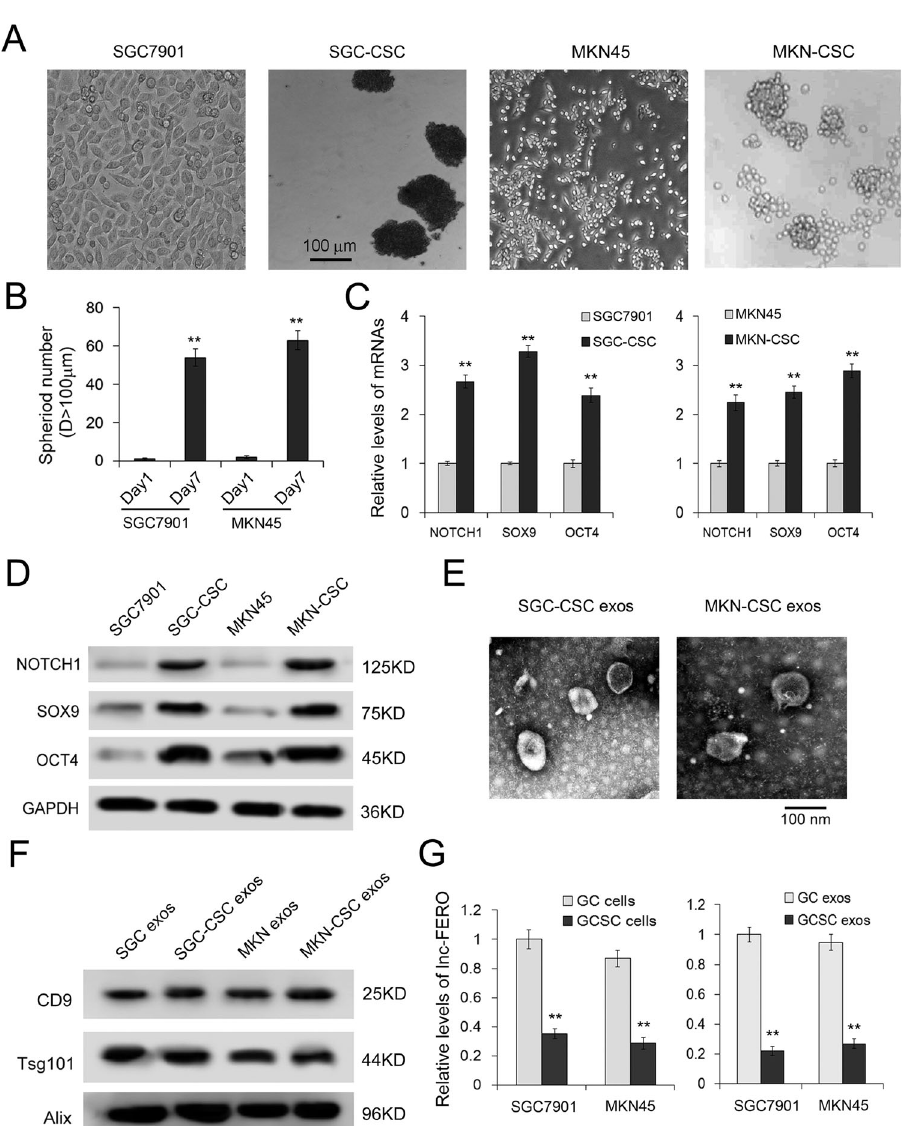
Fig. 3 The different expression characters of lncFERO in GC cells and GC stem cells. A Sphere-formation assays were performed in indicated cell lines. B Number of tumorspheres ( n = 3). C qRT-PCR analysis of stemness-associated genes, including NOTCH1, SOX9, and OCT4, in GC and GCSC cell lines ( n = 3). D Detection of stemness-associated genes by western blotting assay ( n = 3). E Exosomes images obtained from GCSCs were observed by using an electron microscope (scale bar, 100 nm). F Detection of exosome markers, CD9, Tsg101, and Alix, by western blotting assay. G Relative levels of lncFERO in GC cells and GCSCs ( n = 3). ** p <